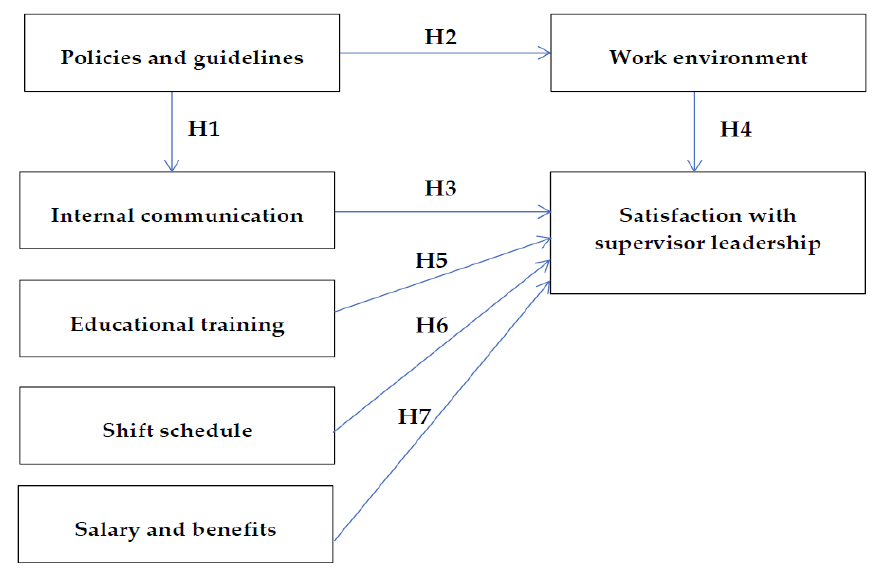
Figure 1. Hypothesized models of this study.